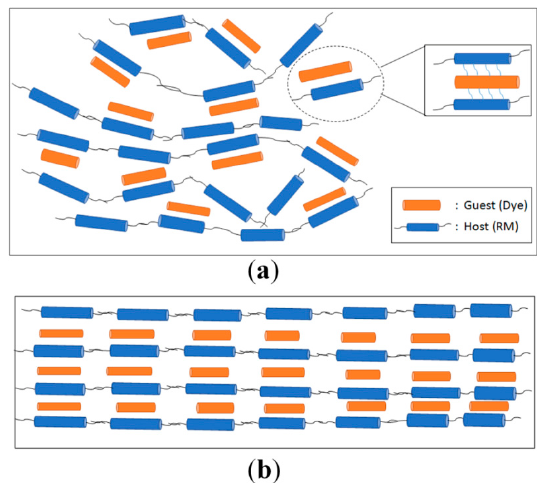
Figure 5. Schematic representation of the photochromic dye distribution determined by the UV-cured RM orientation with the guest-host effect. ( a ) Randomly distributed photochromic dyes on the non-rubbed alignment layer; and ( b ) uniformly distributed photochromic dyes on the rubbed alignment layer.